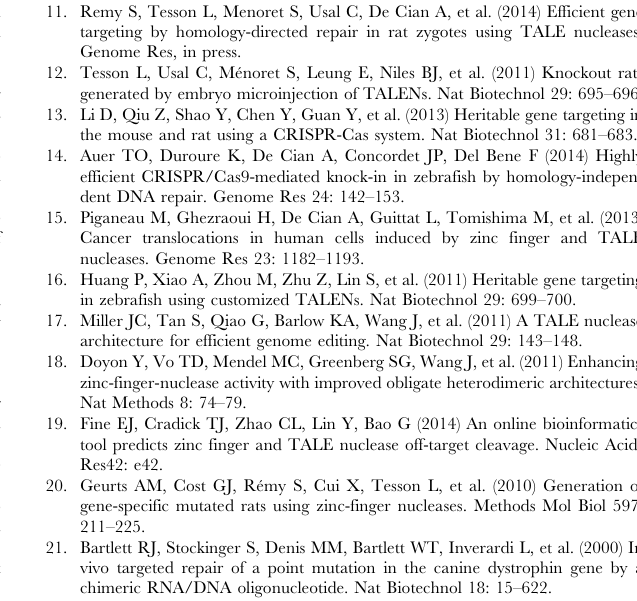
Figure S4 Muscle changes were present in all striated muscle including skeletal, respiratory and cardiac ones